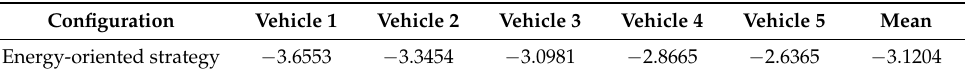
Table 3. Percentage of energy saving in (kWh/km) under energy-oriented architecture with respect to the basic scenario with the proportional controller.